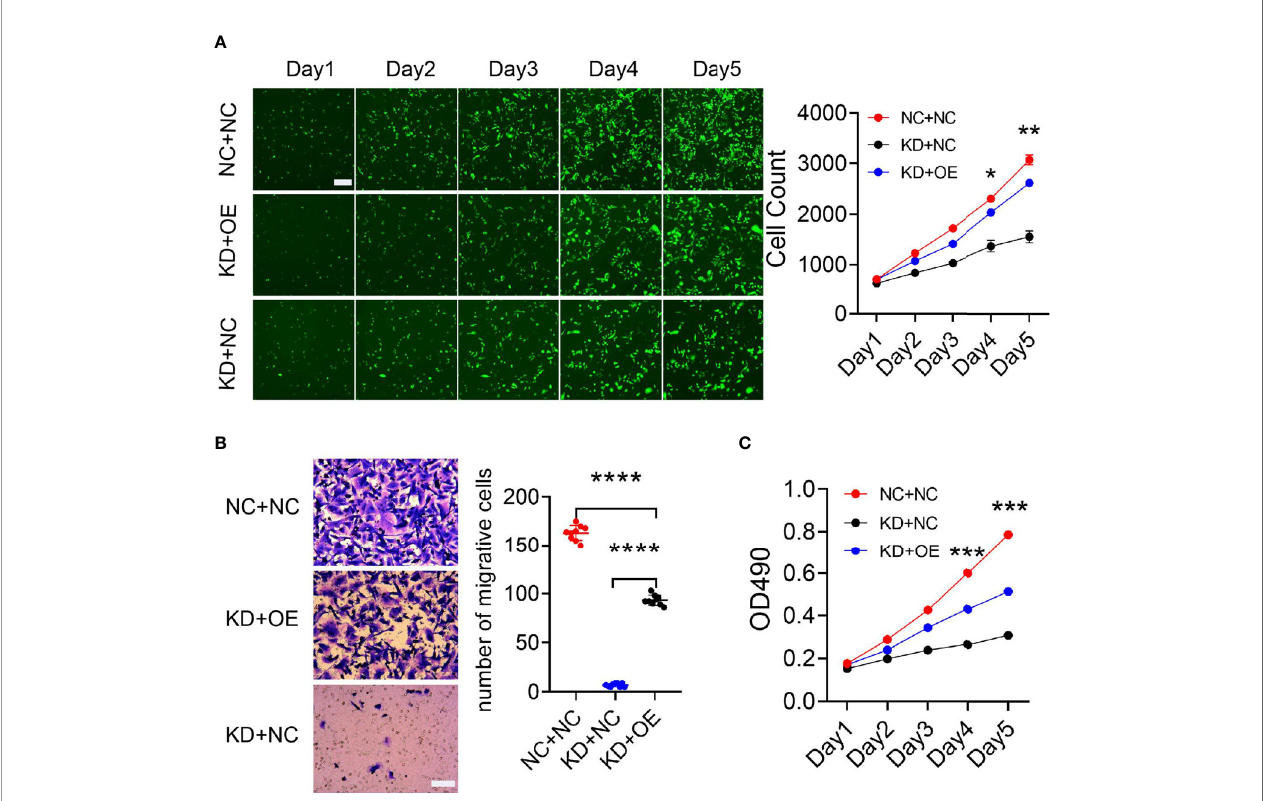
FIGURE 7 | The MDA-MB-231 cell line was used to verify the functional restoration of HLA-B interaction protein genes. (A) The proliferation ability of the cells was evaluated with Celigo apparatus for 5 consecutive days. (B, C) Transwell plate and MTT reagent were used to detect cell migration and cell viability, respectively. These experiments showed that HLA-B protein could restore the proliferation and migration abilities of breast cancer cells, thus further verifying the existence of an interaction between B4GALNT2 and HLA-B protein molecules. (A) Scale bar=100 m m; (B) Scale bar=50 m m. Note: NC+NC=normal control group; KD+OE=knockdown of the B4GALNT2 gene + the overexpressed HLA-B gene; KD+NC=knockdown of the B4GALNT2 gene, only. Note: for the 4 positive interaction proteins identi fi ed (CLU, AXL, HLA-B and EIF4A2), an interference or expression vector was constructed, thus achieving overexpression of the positive interaction protein while inducing interference with the target gene in a cell line. The Celigo instrument scanned the changes in cell proliferation ability for 5 consecutive days, and veri fi ed the functional restoration of the downstream mechanism genes on the target gene. Only the HLA-B gene had an obvious functional restoration effect. *p < 0.05, **p < 0.01, ***p < 0.001, ****p <